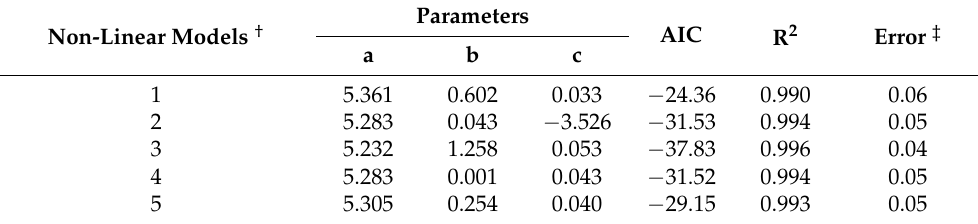
Table 6. Estimated biological parameters, values of Akaike’s information criterion (AIC), coefficient of determination, and absolute error of the adjusted models for the estimation of manure production in the growing–finishing phase, according to the pigs’ housing